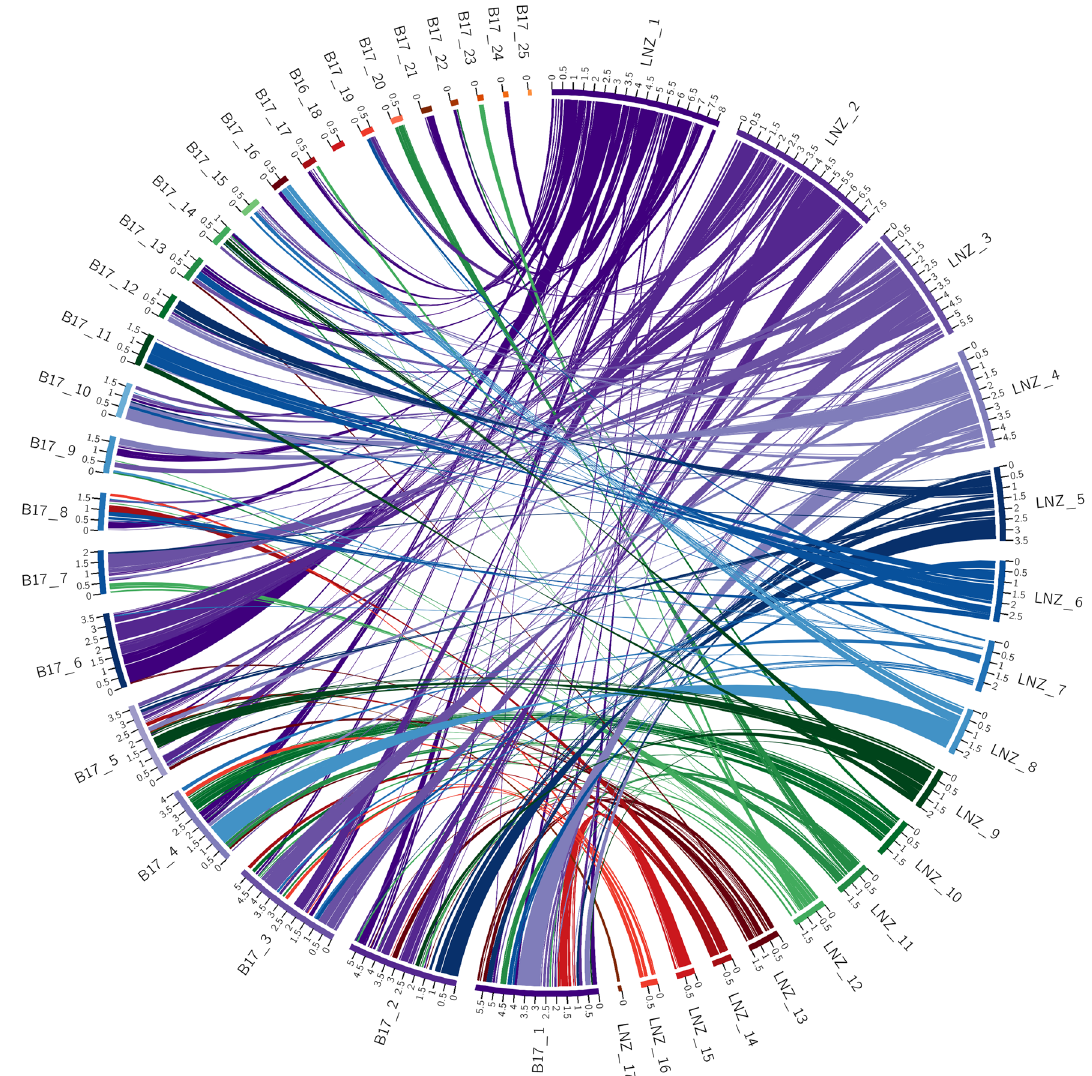
Figure 3. Circos plot of shared syntenic regions between L. edodes B17 and L. novae-zelandiae ICMP 18003. Syntenic regions are connected with colored ribbons scaled to the size of the syntenic regions. These ribbons match the colors of the L. novae-zelandiae ICMP 18003 scaffold blocks. Genomic scaffold lengths are in Mb and are indicated by the numerals on each